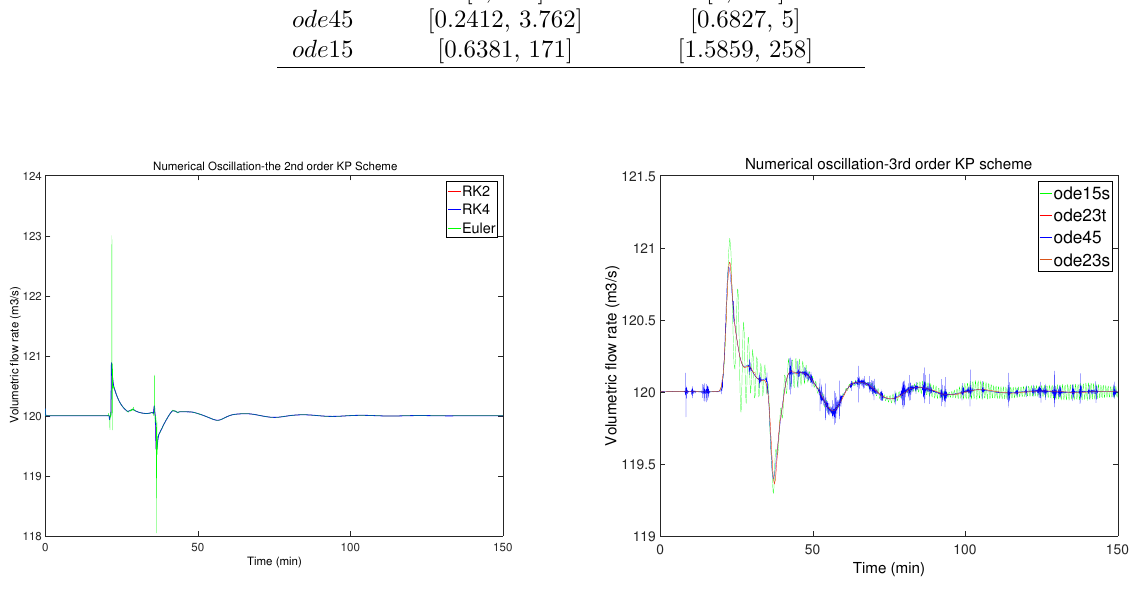
Figure 16: Numerical oscillation for all variable step- length solvers for 3 rd order KP scheme (Dis- sanayake et al.,